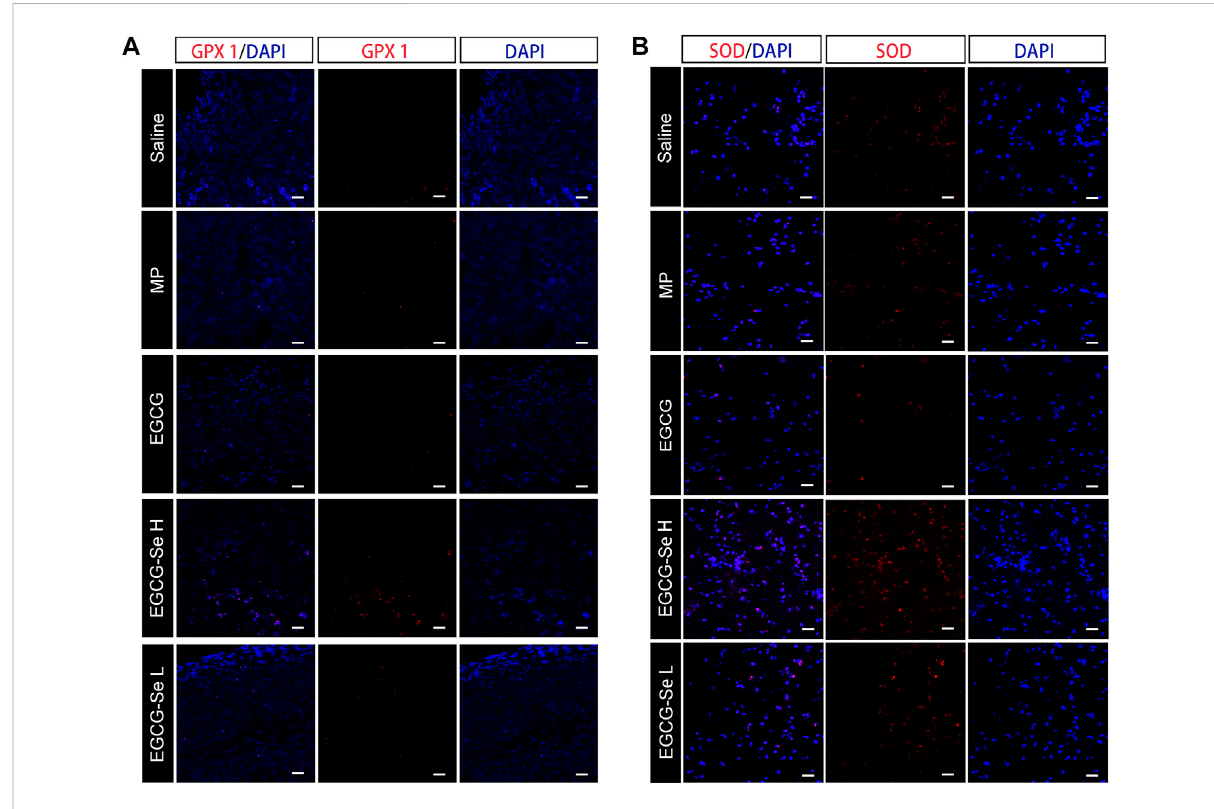
FIGURE 7 Representativeimmunohistochemicalstainingofantioxidantenzymesintheinjuredspinalcord. (A) GPXonestainingat8 weekspost-injury. (B) SOD staining at 1-day post-injury. Scale bars 25 μ